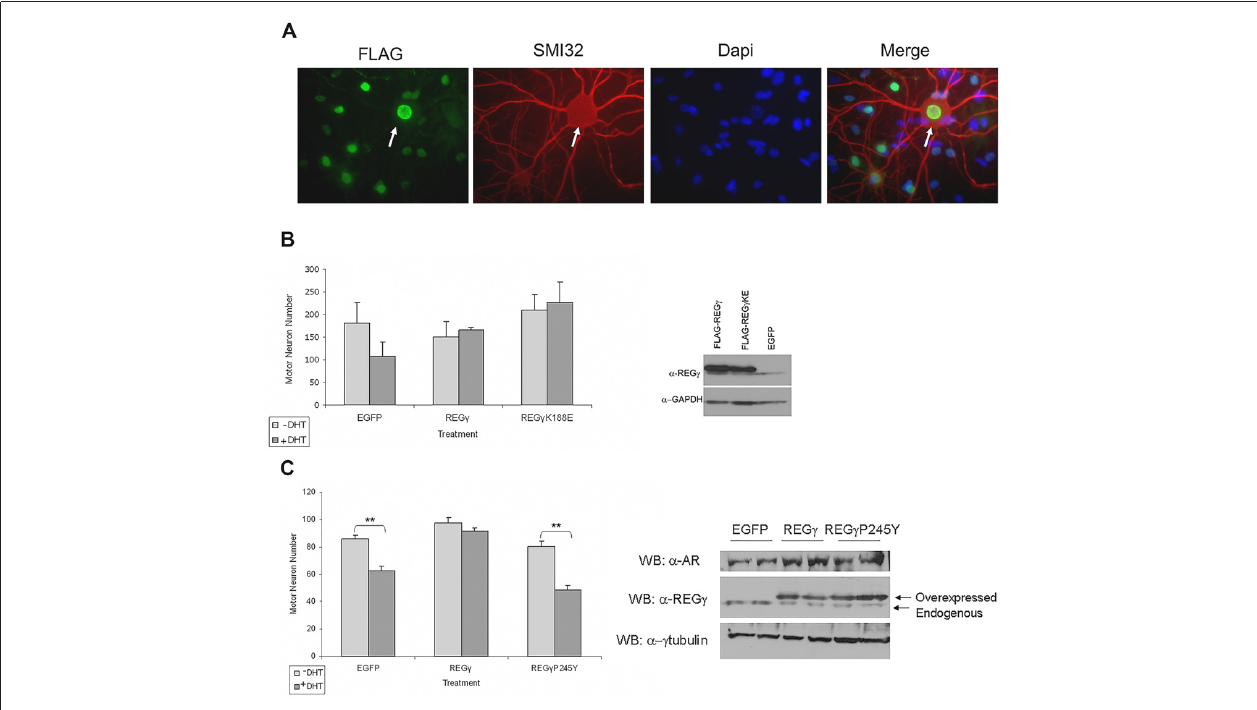
FIGURE 8 | REG γ and REG γ K188E overexpression rescued motor neurons from DHT-dependent death, while REG γ P245Y overexpression did not. (A) Dissociated spinal cord cultures from ARQ112 transgenic mouse embryos were cultured for 3 weeks. Cultures were infected with adeno-associated virus (AAV) expressing REG γ , REG γ K188E or EGFP for 5 days and then treated with or without DHT for 7 days. Cultures were immunostained with FLAG antibody to detect FLAG-REG γ and FLAG-REG γ K188E infected cells, with an antibody against neurofilament heavy chain (SMI32) to reveal motor neurons and stained with Hoechst for nuclei. Arrow indicates a motor neuron infected with nuclear FLAG-REG γ . (B) Left, motor neurons from immunostained cultures in (A) were counted in 10 random fields (2 wells per condition). Two factor ANOVA with post hoc TUKEY HSD was performed. The difference in the number of motor neurons between the +DHT and –DHT conditions for EGFP was not statistically significant ( p = 0.05). Note, however, the complete lack of cell death in the REG γ - and REG γ K188E- expressing cultures. Right, protein lysates from the above cultures were evaluated by Western blot for REG γ and GAPDH (loading control). (C) Left, motor neurons were infected with EGFP, FLAG-REG γ and FLAG-REG γ P245Y expressing AAV for 5 days and treated with or without DHT for 7 days. Cultures were immunostained with SMI32 antibody and motor neurons in 10 random fields in each of three wells per condition were counted. Two factor ANOVA with post hoc TUKEY HSD was performed. ∗∗ p < 0.01. Right, protein lysates were evaluated by Western blot with AR(H280), REG γ and γ -tubulin